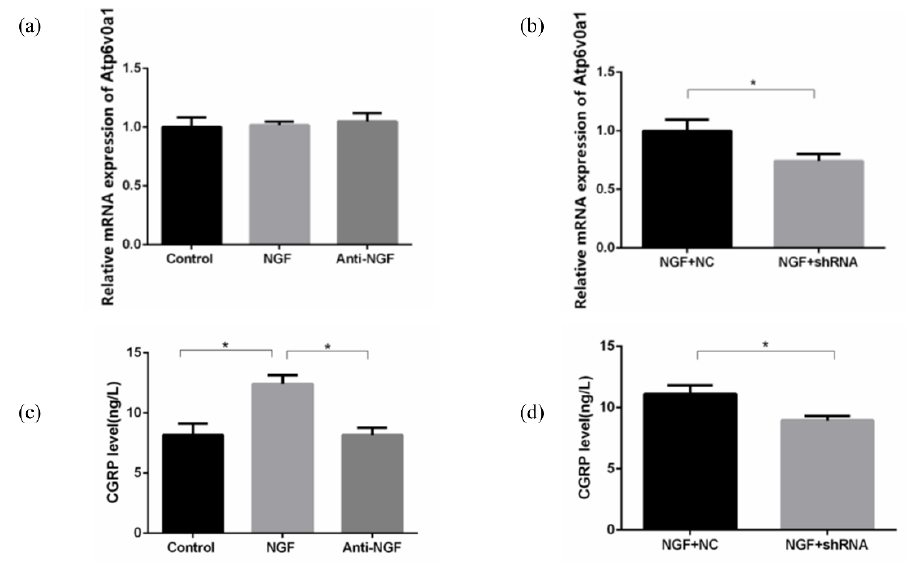
Figure 5. The expression level of Atp6v0a1 and CGRP in SH-SY5Y neurons for Control group, NGF group, Anti-NGF group, NGF + NC group, and NGF + Atp6v0a1 shRNA group. ( a , b ) Real-time polymerase chain reaction results for Atp6v0a1 expression level. ( c , d ) Enzyme-Linked Immunosorbent Assy (ELISA) results for CGRP expression level (Data are presented as mean ± SD. *: p < 0.05).